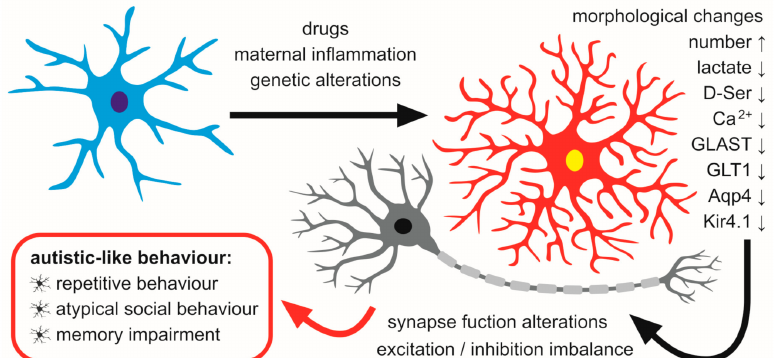
Figure 2. The possible role of astrocytes in the development of autism. Genetic mutations, prenatal exposition on some drugs and prenatal inflammation affect astrocytic morphology and functions. It may result in alterations of synapse functions, imbalanced homeostasis between excitation and inhibition and dysregulation of the nervous system. This, in turn, may lead to autistic-like behavioural changes. D-Ser: D-serine; GLAST, GLT-1: glutamate transporters; Aqp4: aquaporine 4; Kir4.1: inward rectifying K +